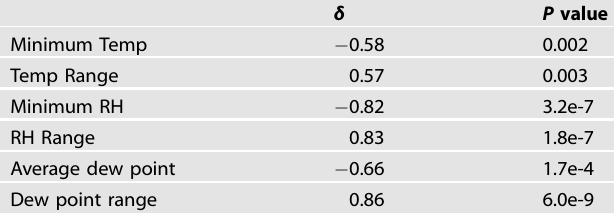
Table 3. Partial Spearman correlation* of Salmonella persister switch rate α with speci fi c 8-h weather